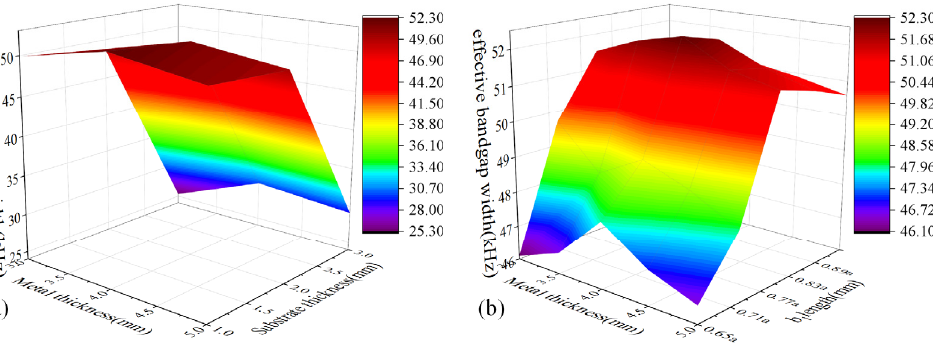
Figure 5. ( a ) The effect of h 1 and h 2 on effective bandgap width; ( b ) the effect of h 1 and b 1 on effective bandgap width.